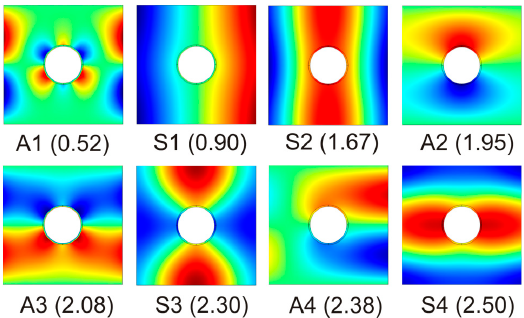
Figure 8. z -displacement of the brass unit cell for a fixed value of k ‖ · a / π = 0.4 The eigenmodes are labeled as S (symmetric) or A (antisymmetric) according to they behaviour to the horizontal plane wave incoming from the left side of the plots. The eigenmodes normalized frequency k 0 · a / π values are despited in parenthesis. The displacement is represented in linear scale.